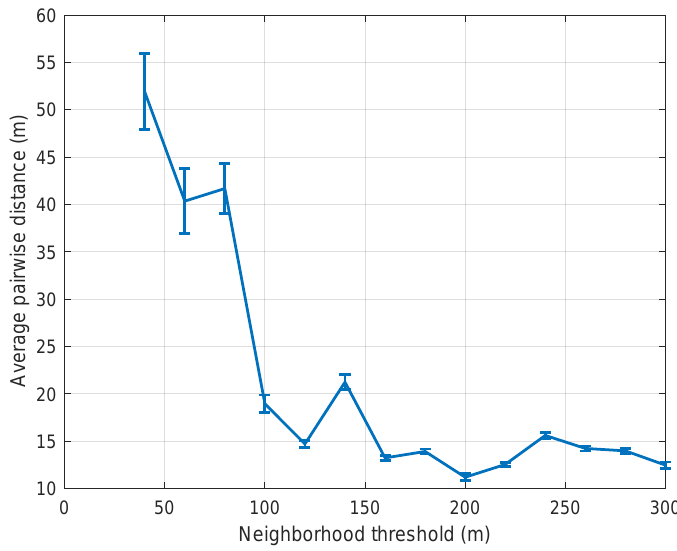
Figure 7. Average pairwise distance with respect to neighborhood